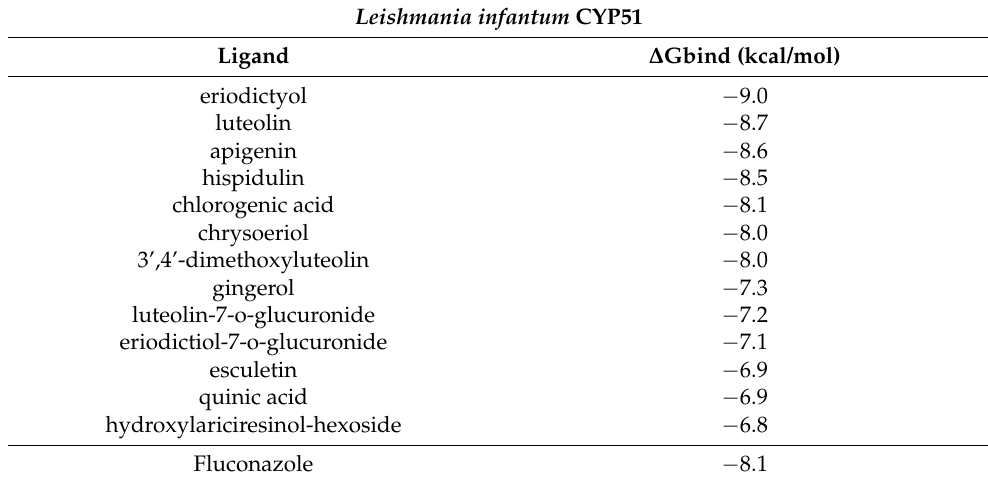
Table 2. Values of the free energy binding parameters of the compounds identified in the Vernonan- thura brasiliana (L.) H. Rob extract with the Leishmania infantum